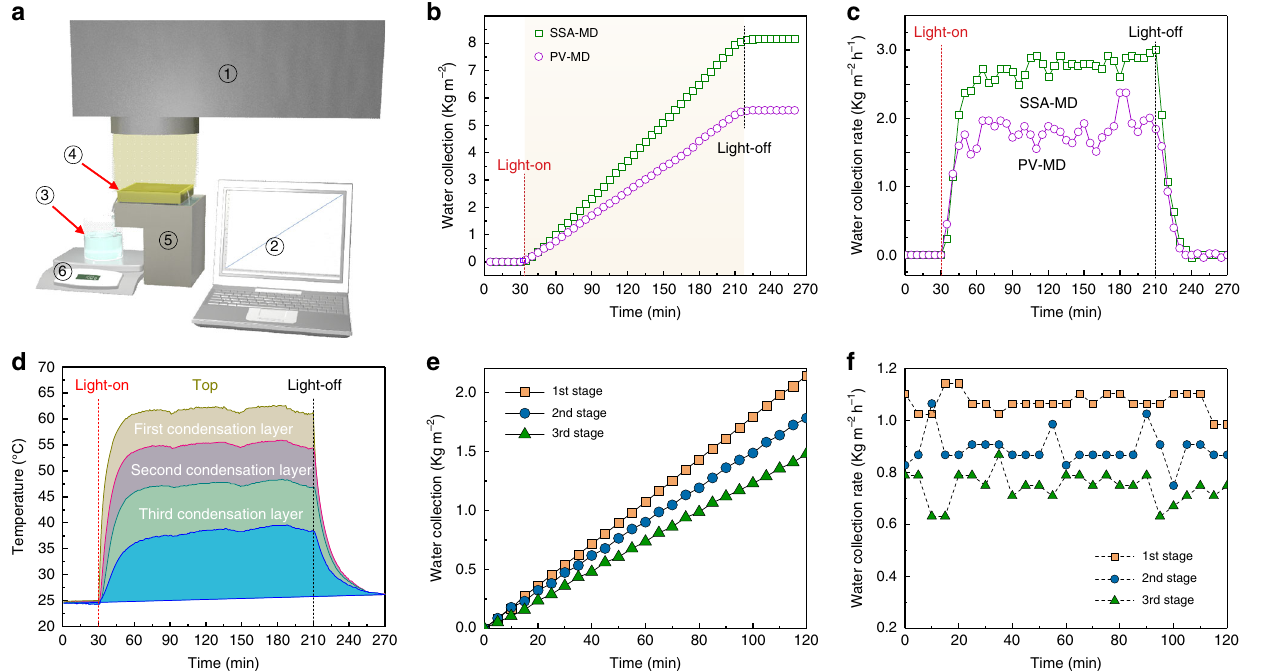
Fig. 3 Water production evaluation of the multistage membrane distillation (MSMD) device. a Schematic representation of the experimental setup ( ① Solar simulator, ② computer ③ , clean water collector, ④ photovoltaics/spectrally selective absorber-membrane distillation (PV-MD/SSA-MD), ⑤ source water container, ⑥ electrical balance). b The mass change rates of the collected water under one sun irradiation (starting from the red dash line) and dark (starting from the black dash line), and c water production rates of a three-stage dead-end PV-MD/SSA-MD devices, d temperature pro fi le, e the mass change of the collected water and f the water production rate of each stage of the three-stage dead-end SSA-MD